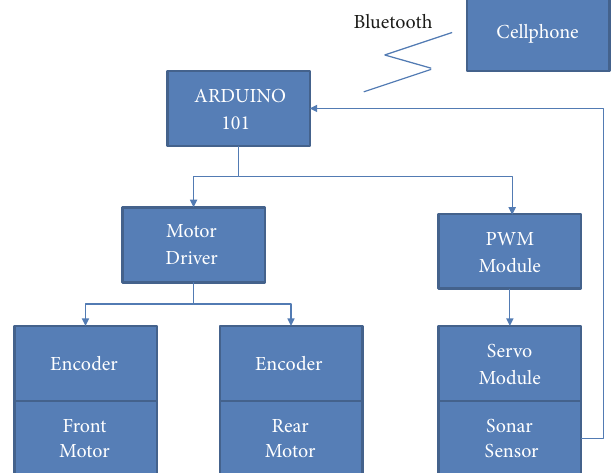
Figure 5: System architecture.